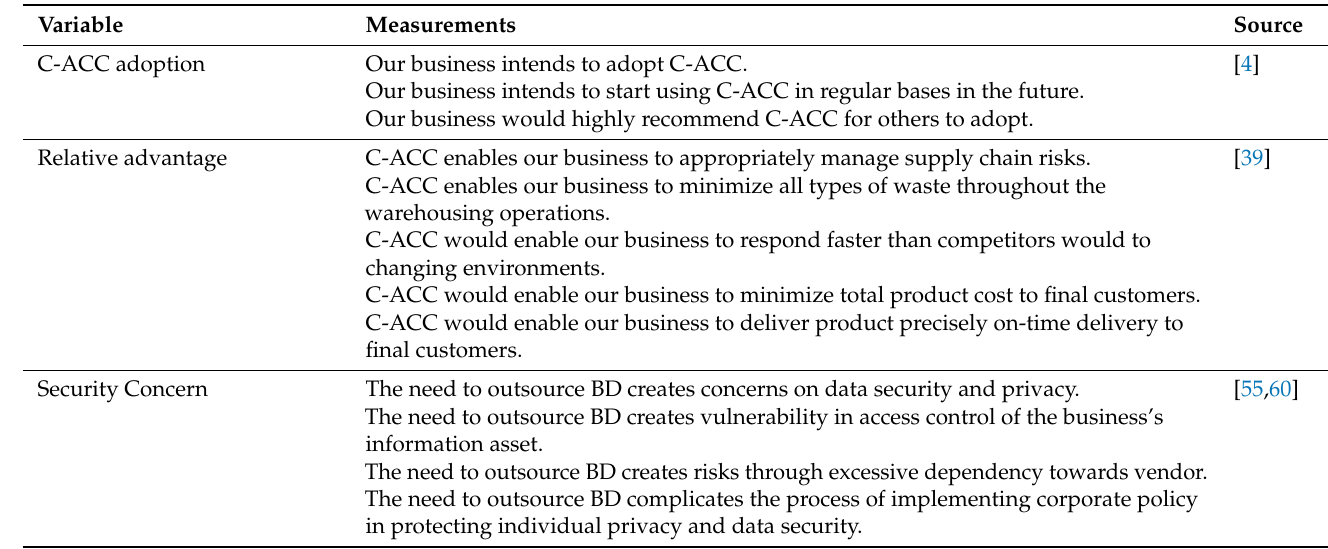
Table A1. Variables with measurement items